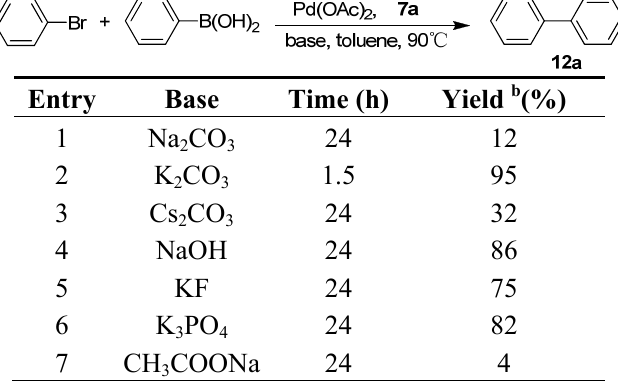
Table 1. Influence of the base on the Suzuki-Miyaura reaction catalyzed by Pd(OAc)